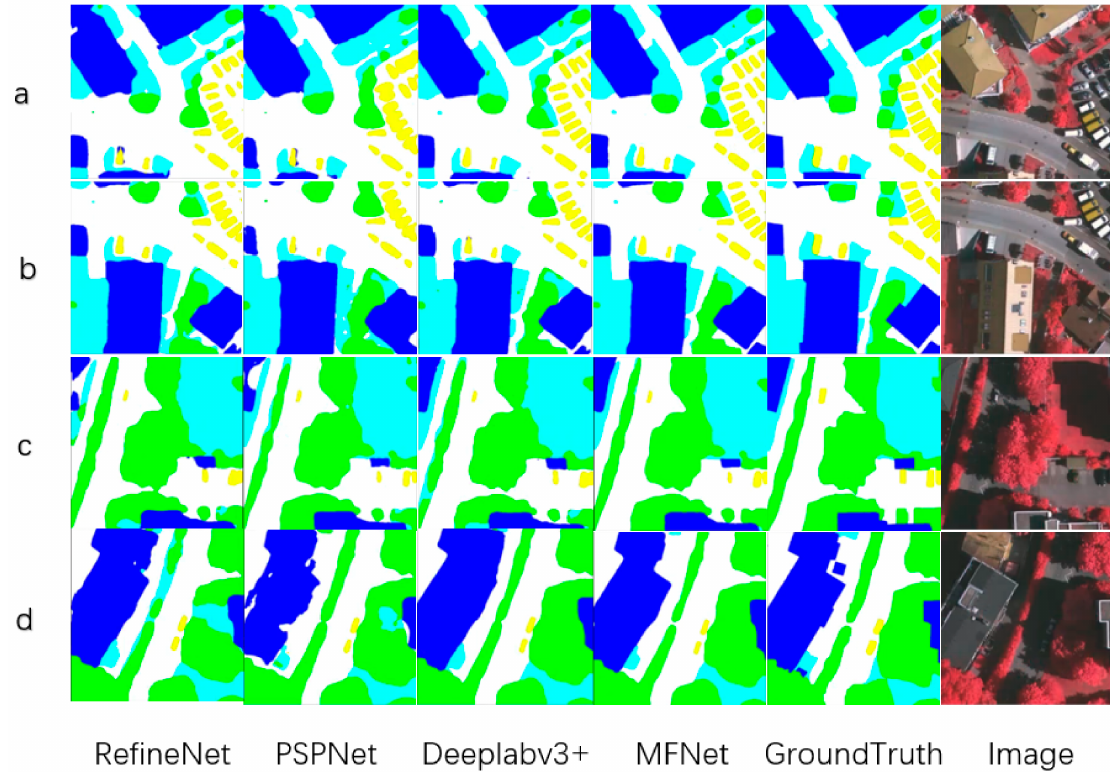
Figure 5. The result visualization of MFNet in Vaihingen dataset’s local area compare with other network ( a – d